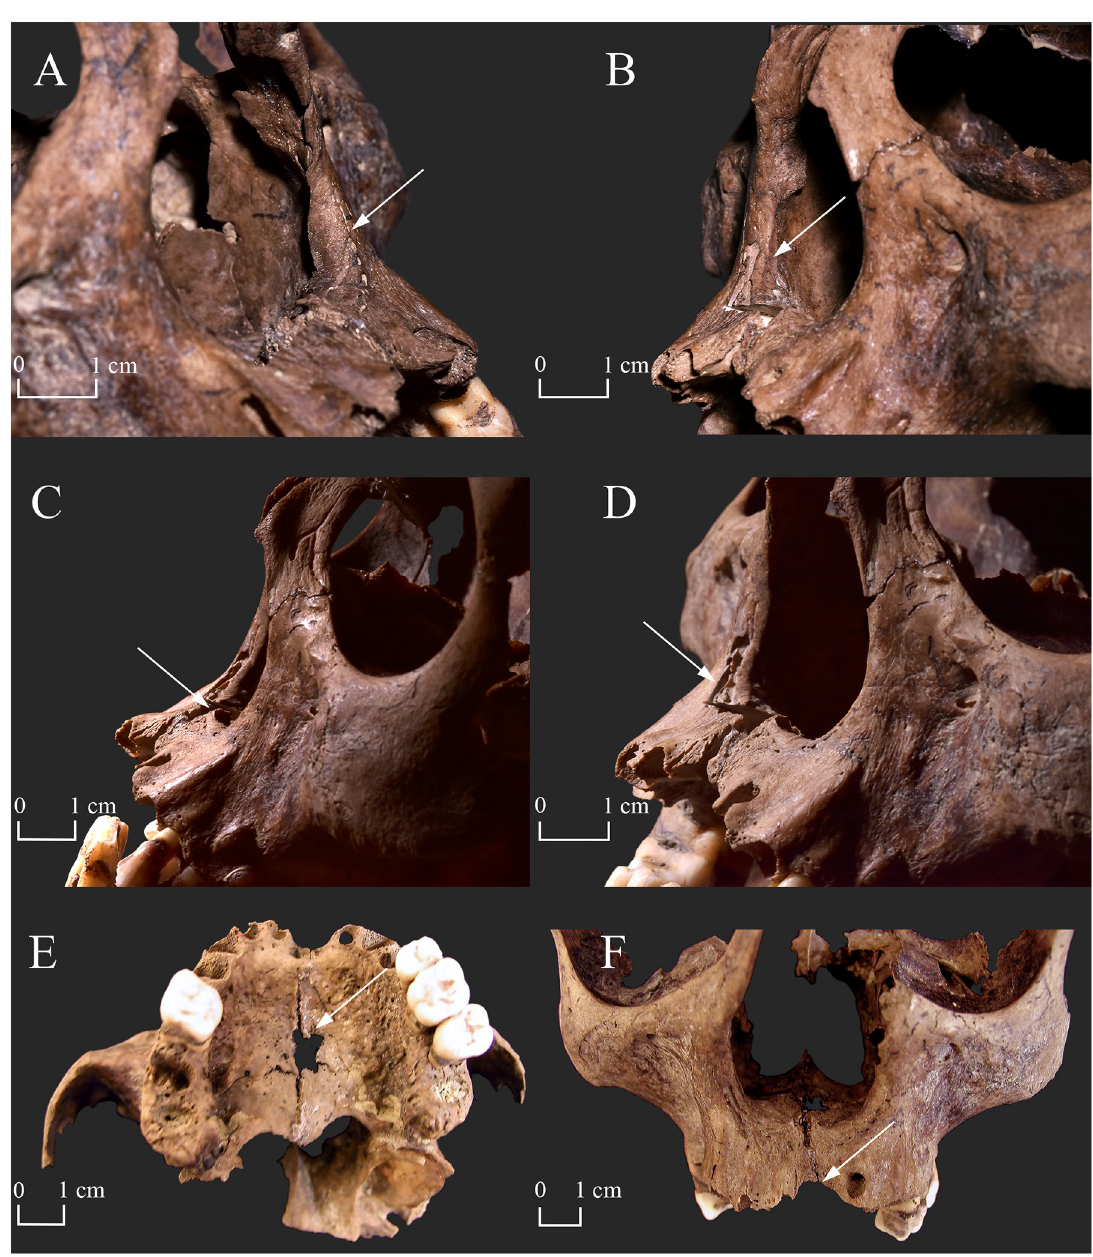
Fig 4. Rhinomaxillary lesions in the skull of KD271. A) Resorption of the anterior nasal spine and the left inferior nasal concha, and widening and rounding of the inferior half of the pyriform aperture (left side–white arrow); B) Resorption of the anterior nasal spine and the right inferior nasal concha, and widening and rounding of the inferior half of the pyriform aperture (right side–white arrow); C) Resorption of the anterior nasal spine (white arrow); D) Resorption of the anterior nasal spine and the maxillary alveolar process (at the prosthion), and vascular impressions in the inferior margin of the pyriform aperture (right side–white arrow); E) Pitting and perforation (white arrow) on the oral surface of the maxillary palatine process, and resorption of the maxillary alveolar process (at the prosthion); and F) Widening and rounding of the inferior half of the pyriform aperture, perforation of the nasal surface of the maxillary palatine process, and resorption of the nasal septum, the anterior nasal spine, and the maxillary alveolar process (at the prosthion–white arrow). (Photos A–D were taken after sampling for aDNA analysis, whereas photos E–F were taken before sampling for aDNA